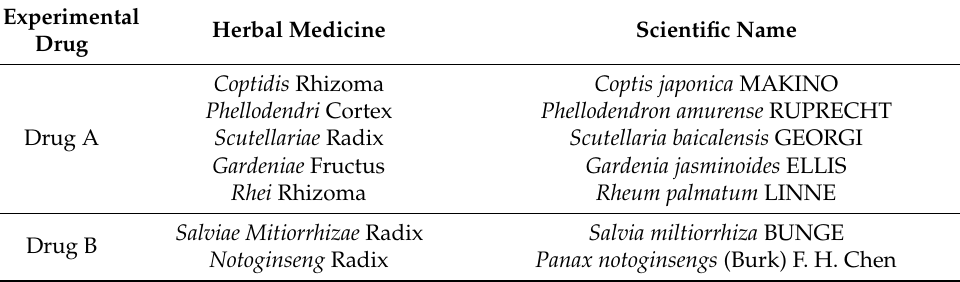
Table 1. Constituent herbal medicines of experimental drugs A and B.